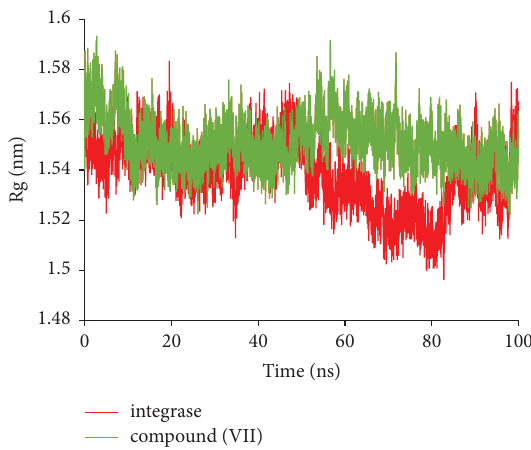
Figure 11: Plot of changes in Rg of alpha carbon integrase during 100ns of simulation in connection with compound VII for inte- grase in red and for integrase in the presence of compound VII in green.